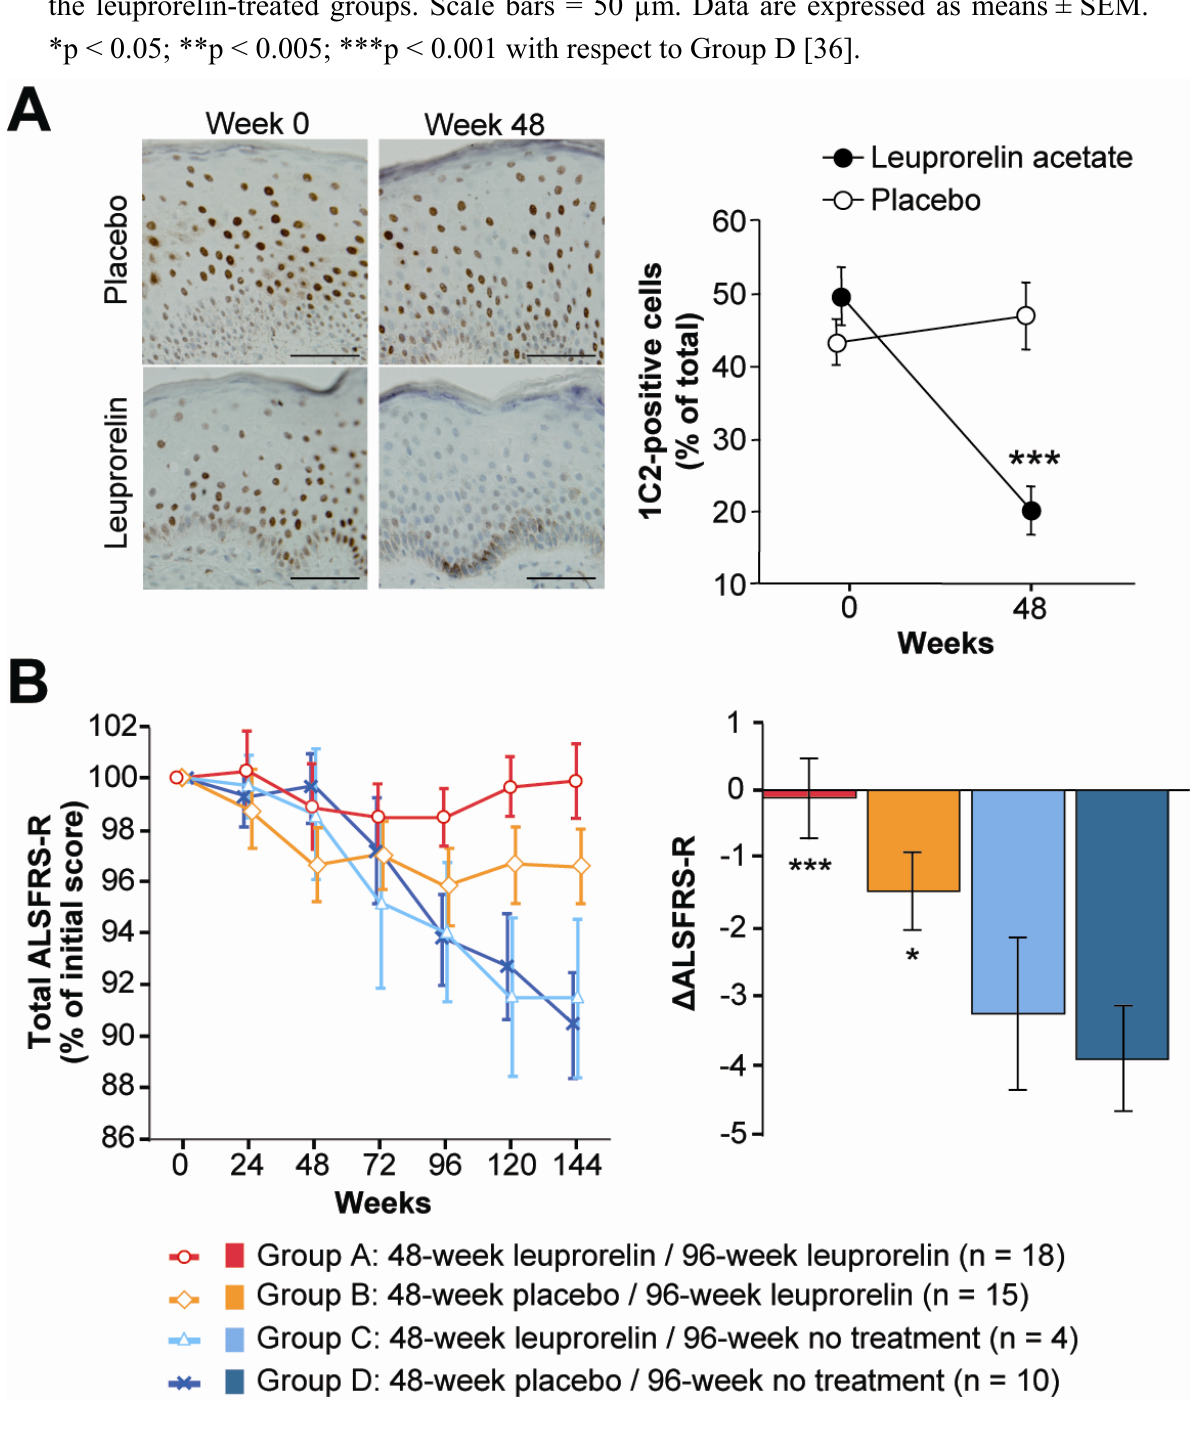
Figure 3. Efficacy results of leuprorelin in SBMA patients. (A) The frequency of diffuse nuclear 1C2 staining (indicative of mutant AR) in the scrotal epithelial cells was significantly decreased after the 48-week administration of leuprorelin acetate. (B) Changes in the ALSFRS-R scores showed treatment duration-dependent improvements in the leuprorelin-treated groups. Scale bars = 50 µm. Data are expressed as means ± SEM. *p < 0.05; **p < 0.005; ***p < 0.001 with respect to Group D